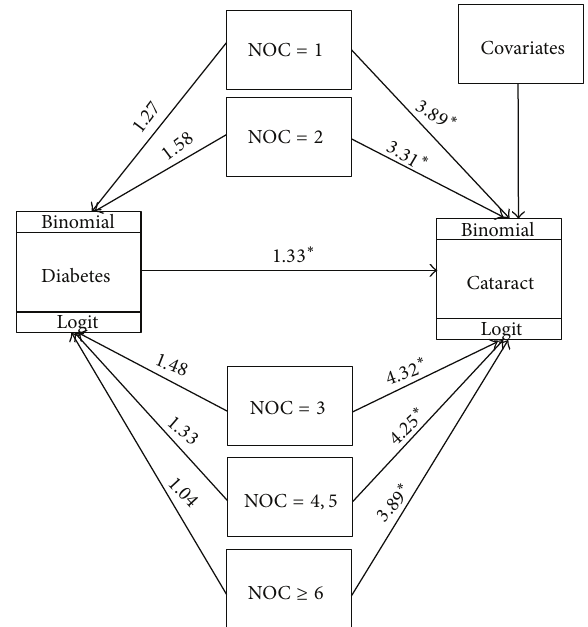
Figure 1: Path diagram of structural equation modeling to depict the relationships among number of children (NOC), diabetes, cataract, and the other nine covariates. The covariates included age, hypertension status, dietary salt intake, residence, education, occupation, marital status, smoking history, and alcohol drinking ( ∗ 𝑃 < 0.05